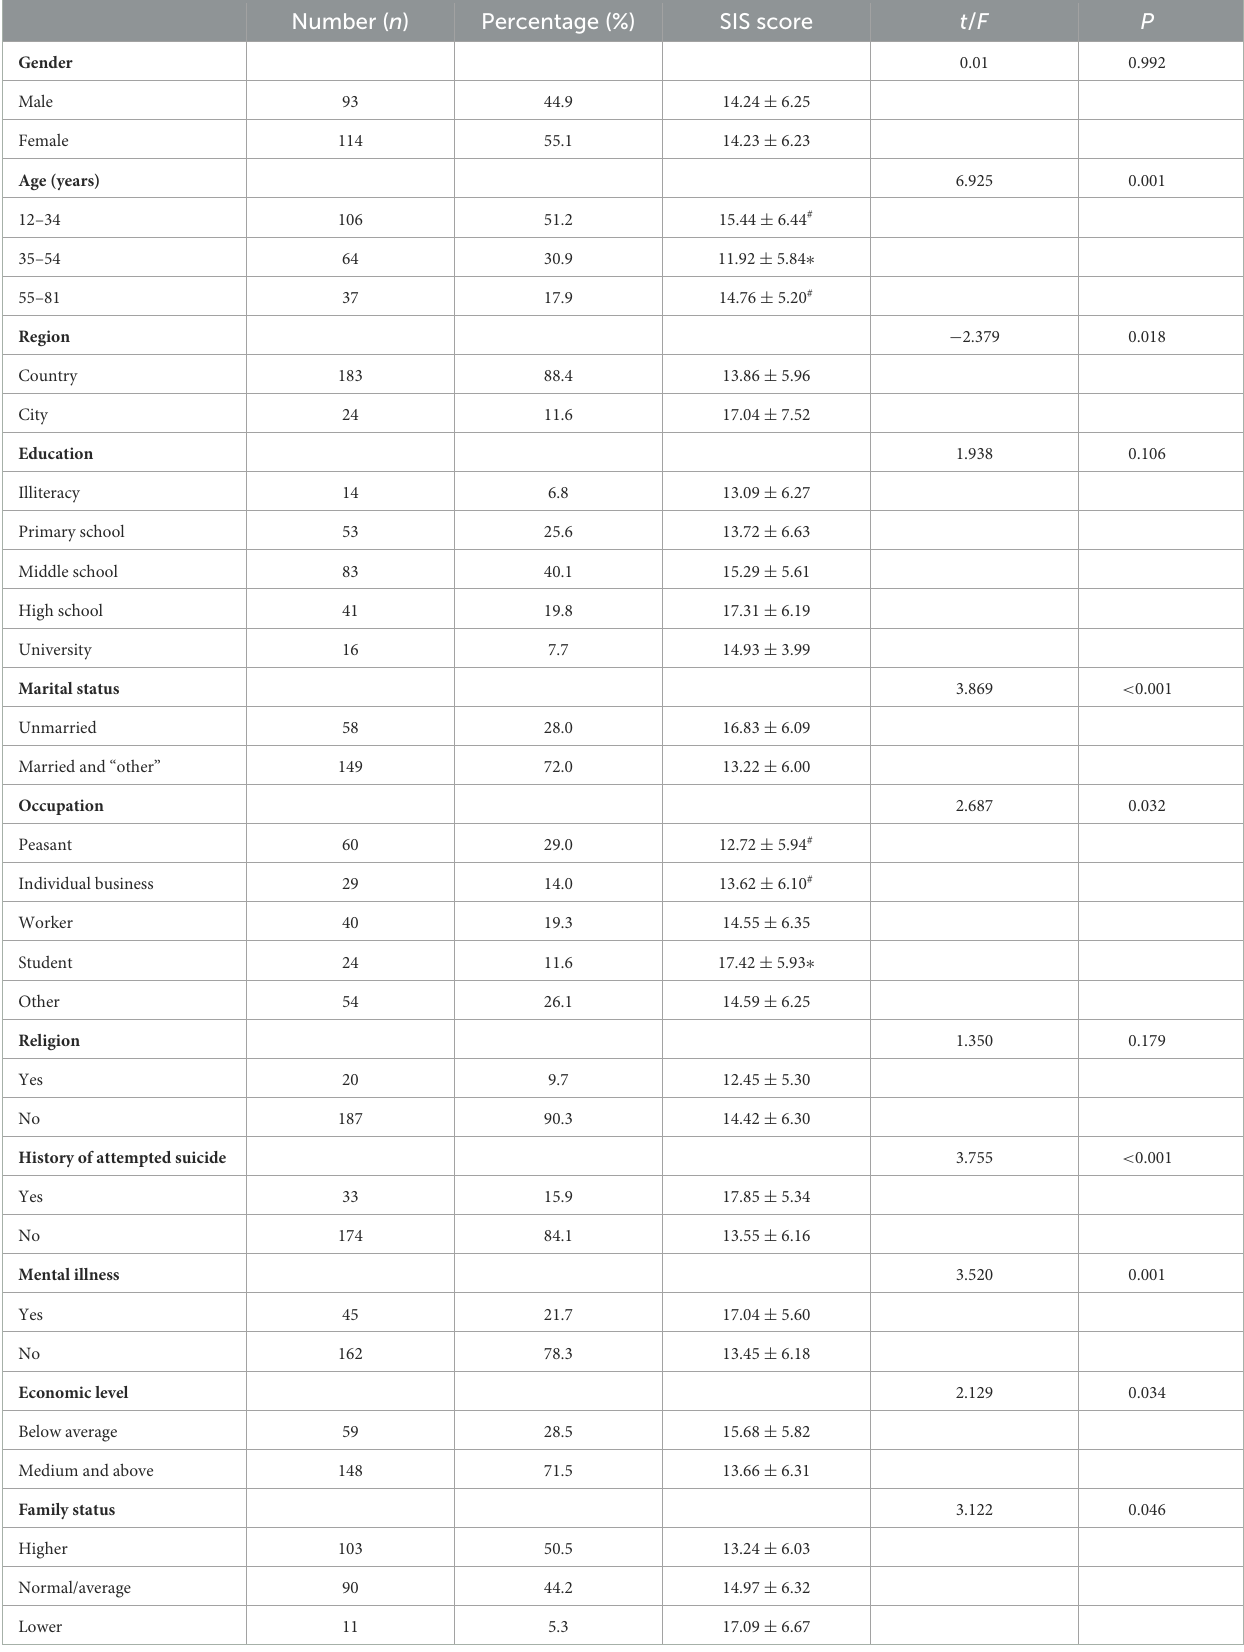
TABLE 1 Demographic information and single-factor analysis in patients with intentional acute pesticide poisoning ( n =